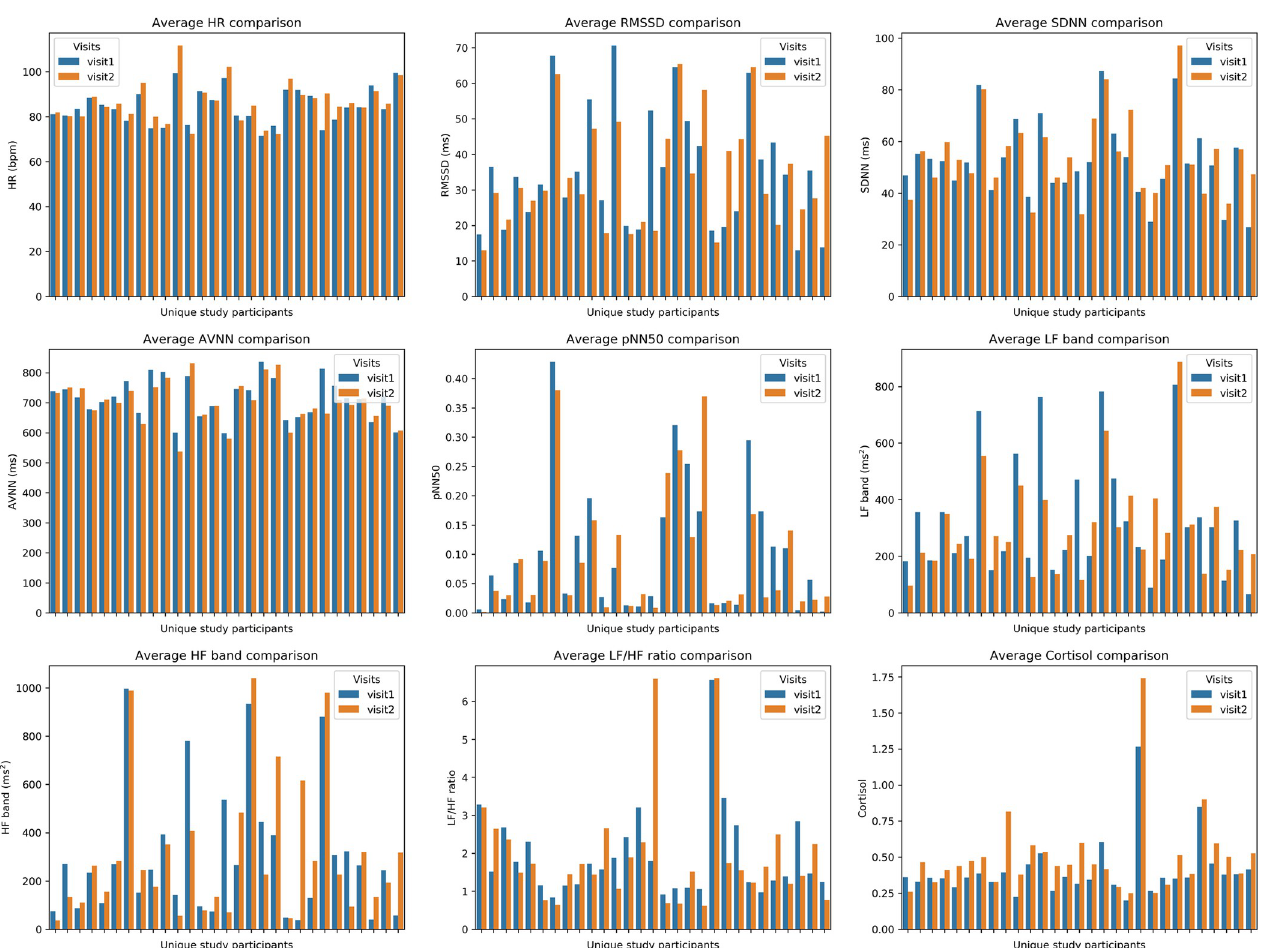
Fig 5. Comparison of average values for HR, HRV parameters, and cortisol between visit 1 and visit 2 for all 29 participants.